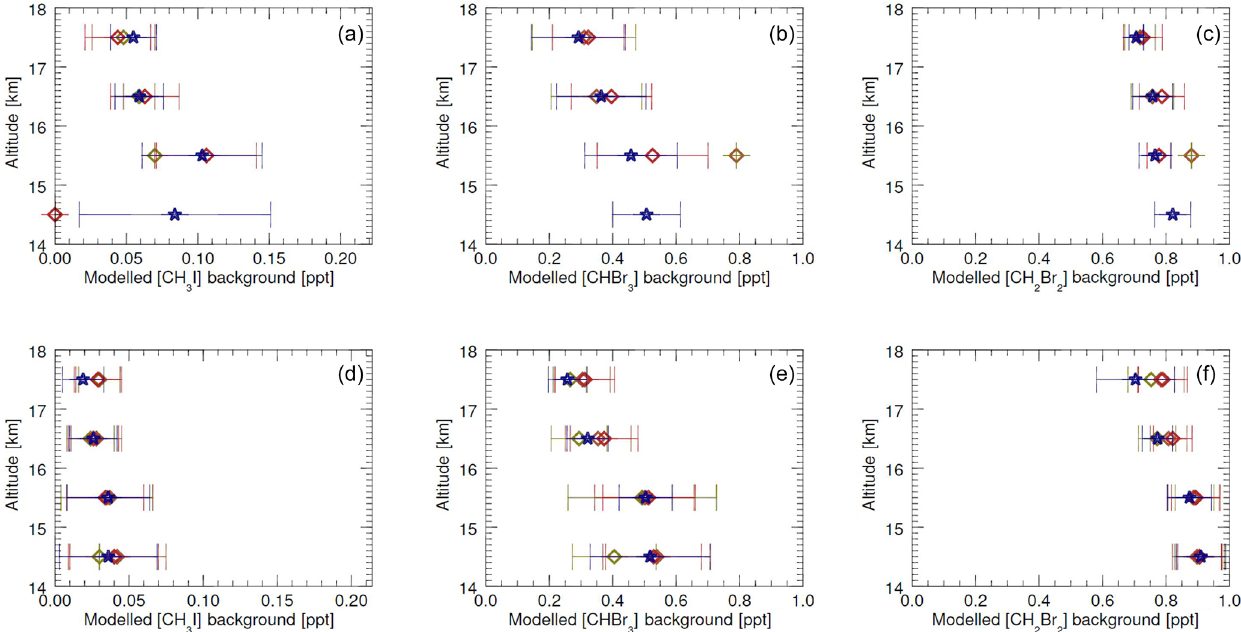
Figure 5. Background mixing ratios for CH 3 I, CHBr 3 and CH 2 Br 2 for all NAME runs for all flights in ATTREX 2014 (a–c) and ATTREX 2013 (a–f) . Little convective influence is indicated by selecting means from NAME 1km fractions of <1 (blue star), 5 (red diamond) and 10% (green